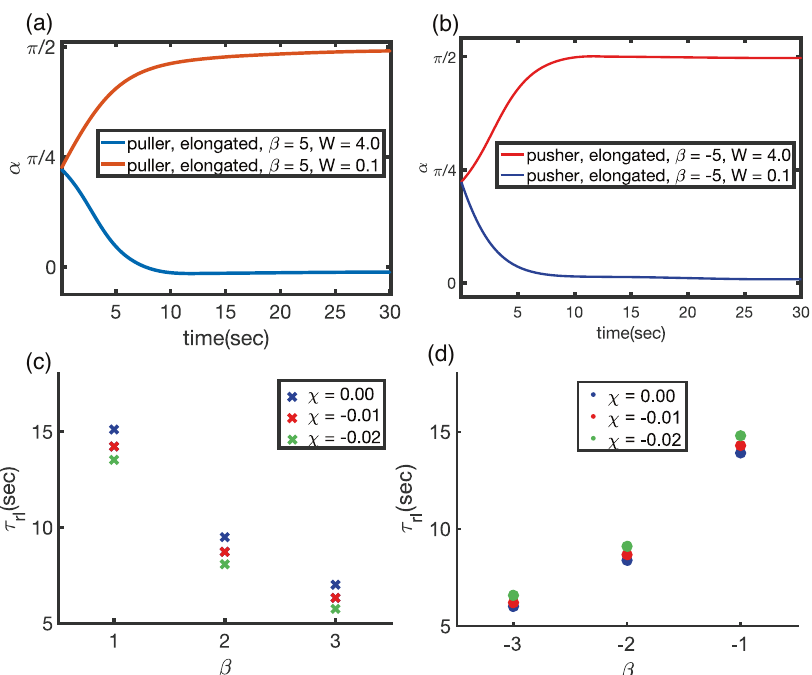
Fig. 2 Orientation dynamic of a single swimmer. a Orientation angle of a puller with strong (blue) and weak planar anchoring (red). b Orientation angle of a pusher with strong (red) and weak homeotropic anchoring (blue). c , d Relaxation time τ rl vs. β for different values of coupling parameter χ when planar anchoring strength W = 0.1. Positive β corresponds to pullers and β < 0 to pushers.